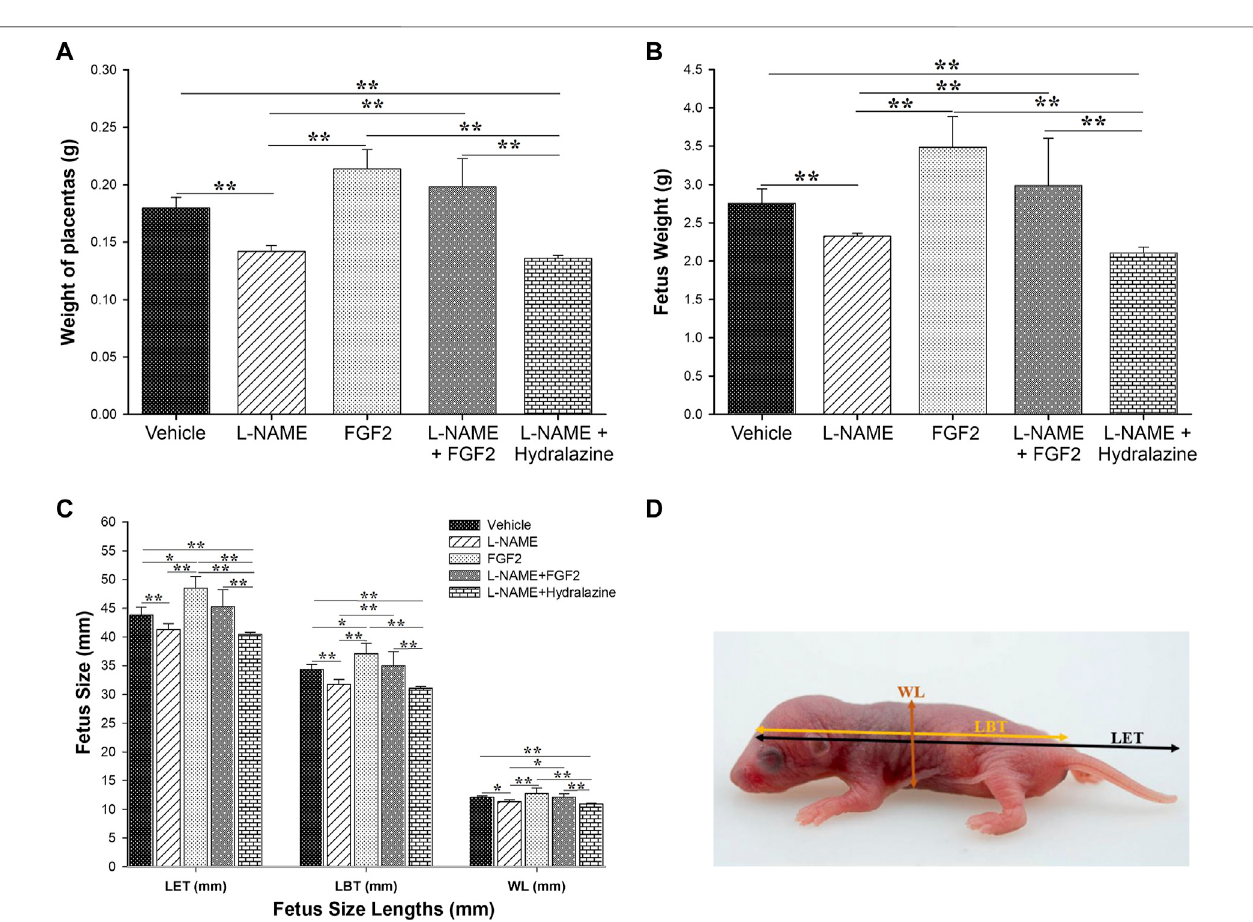
FIGURE5| Effectofadministrationof666.6 ng/kgofrhFGF2onplacentalweightandfetalgrowthinthePE-likemodelinducedbyL-NAME.Themeanofweightoftheplacenta andfetusesareshownin (A,B) . (C,D) showsthethreedifferentmeasurementoffetus(lengthtotailbase,lengthtoendoftailandwidthlength)classi fi edperexperimentalgroup.Dataare expressedasmean ± standarderrorofsevenrats. p -valueswereobtainedusingonewayANOVAcoupledwiththeDunn ’ smethod.* p < 0.05,** p < 0.001.LBT,lengthtotailbase;LET, length to end of tail; WT, width length.